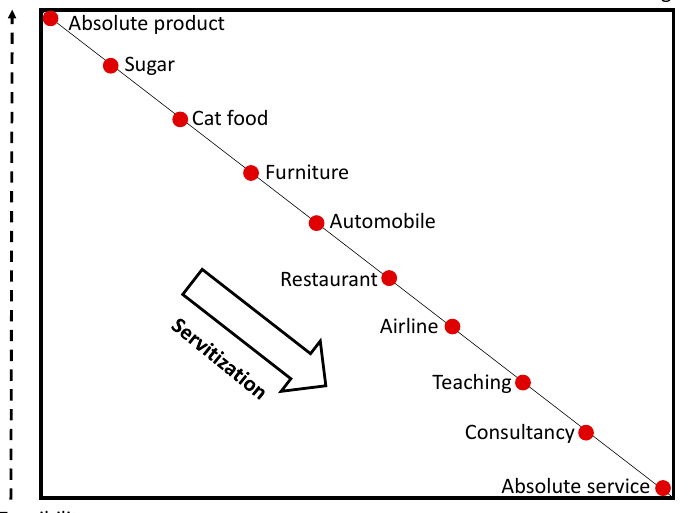
Figure 1. Products and services differentiated on a tangibility/intangibility continuum, which sets the basis for defining products and services, inferred from [13,17]. Here, servitization is defined as the repositioning of any offering on the tangibility/intangibility continuum towards the intangibility side; e.g., an automobile can be servitized by including additional services such as self-driving features.